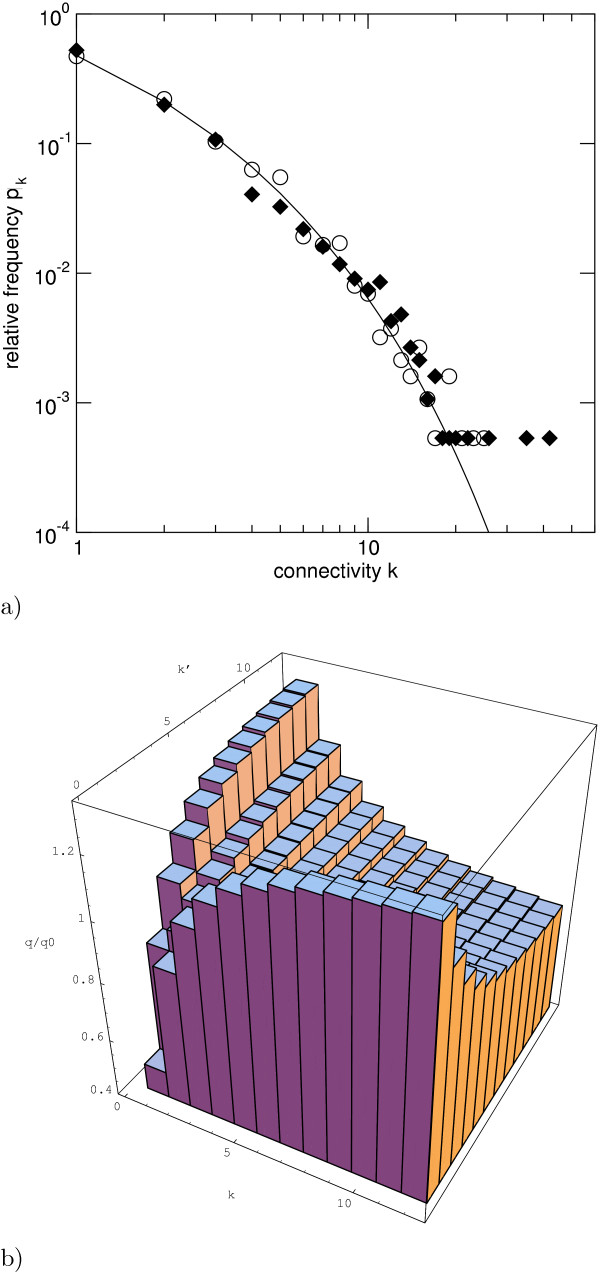
(a) The asymmetric link dynamics produces a broad connectivity distribution. The model prediction of the connectivity distribution of nodes with non-zero connectivity agrees well with yeast protein interaction data (filled diamonds). The solution of the rate equation (4) is shown as a solid line, the result of a computer simulation emulating the link dynamics encapsulated in (4) for a network of finite size is shown as circles (°). Nodes with the highest k (lower right) occur only once in the network. (b) High-connectivity vertices are preferentially connected to low-connectivity vertices, as also observed empirically. The figure shows the relative likelihood of the link distribution  and the 'null distribution'  of an uncorrelated random network, see text.